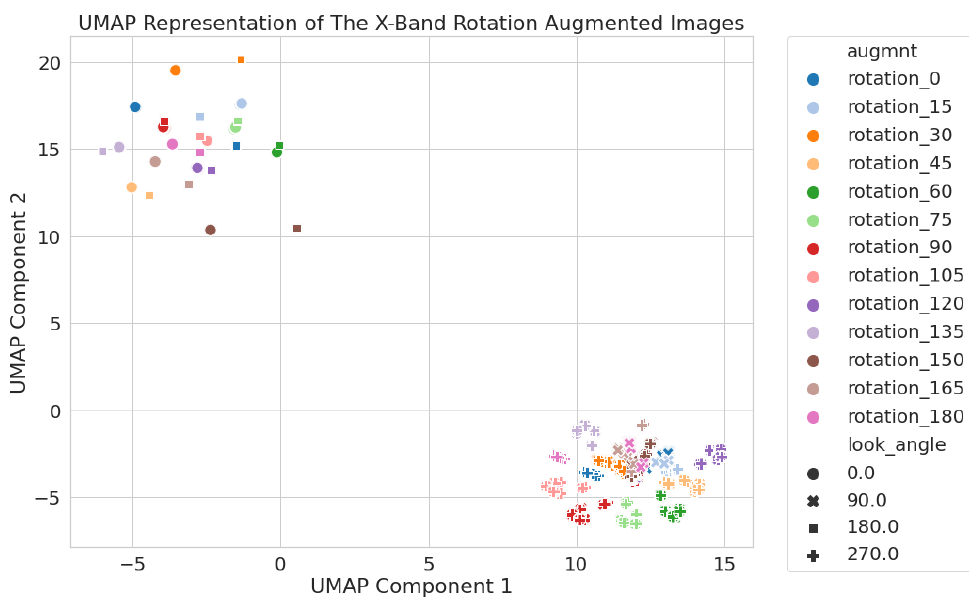
Figure 7. X-band only 2D UMAP latent space using circular crop images. All rotation augmentations are used, and the results show two clusters of images based on the look angle, 0 ◦ and 180 ◦ in the upper left and 90 ◦ and 270 ◦ are in the lower right. The 90 ◦ and 270 ◦ look angle images form a pattern similar to C-band (Figure 5), while the 90 ◦ and 270 ◦ look angle images form a pattern similar to S-band (Figure